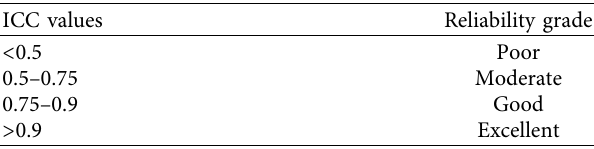
Figure 6: 3DPMs of PHF used in the following study. Table 1: ICC values interpretation according to Ko and Li